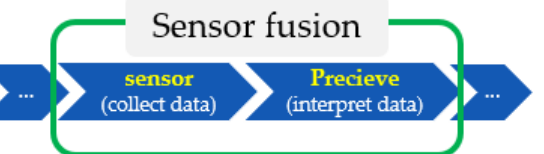
Figure 14. Sensor fusion involves merging the data collected from sensors and producing knowledge.